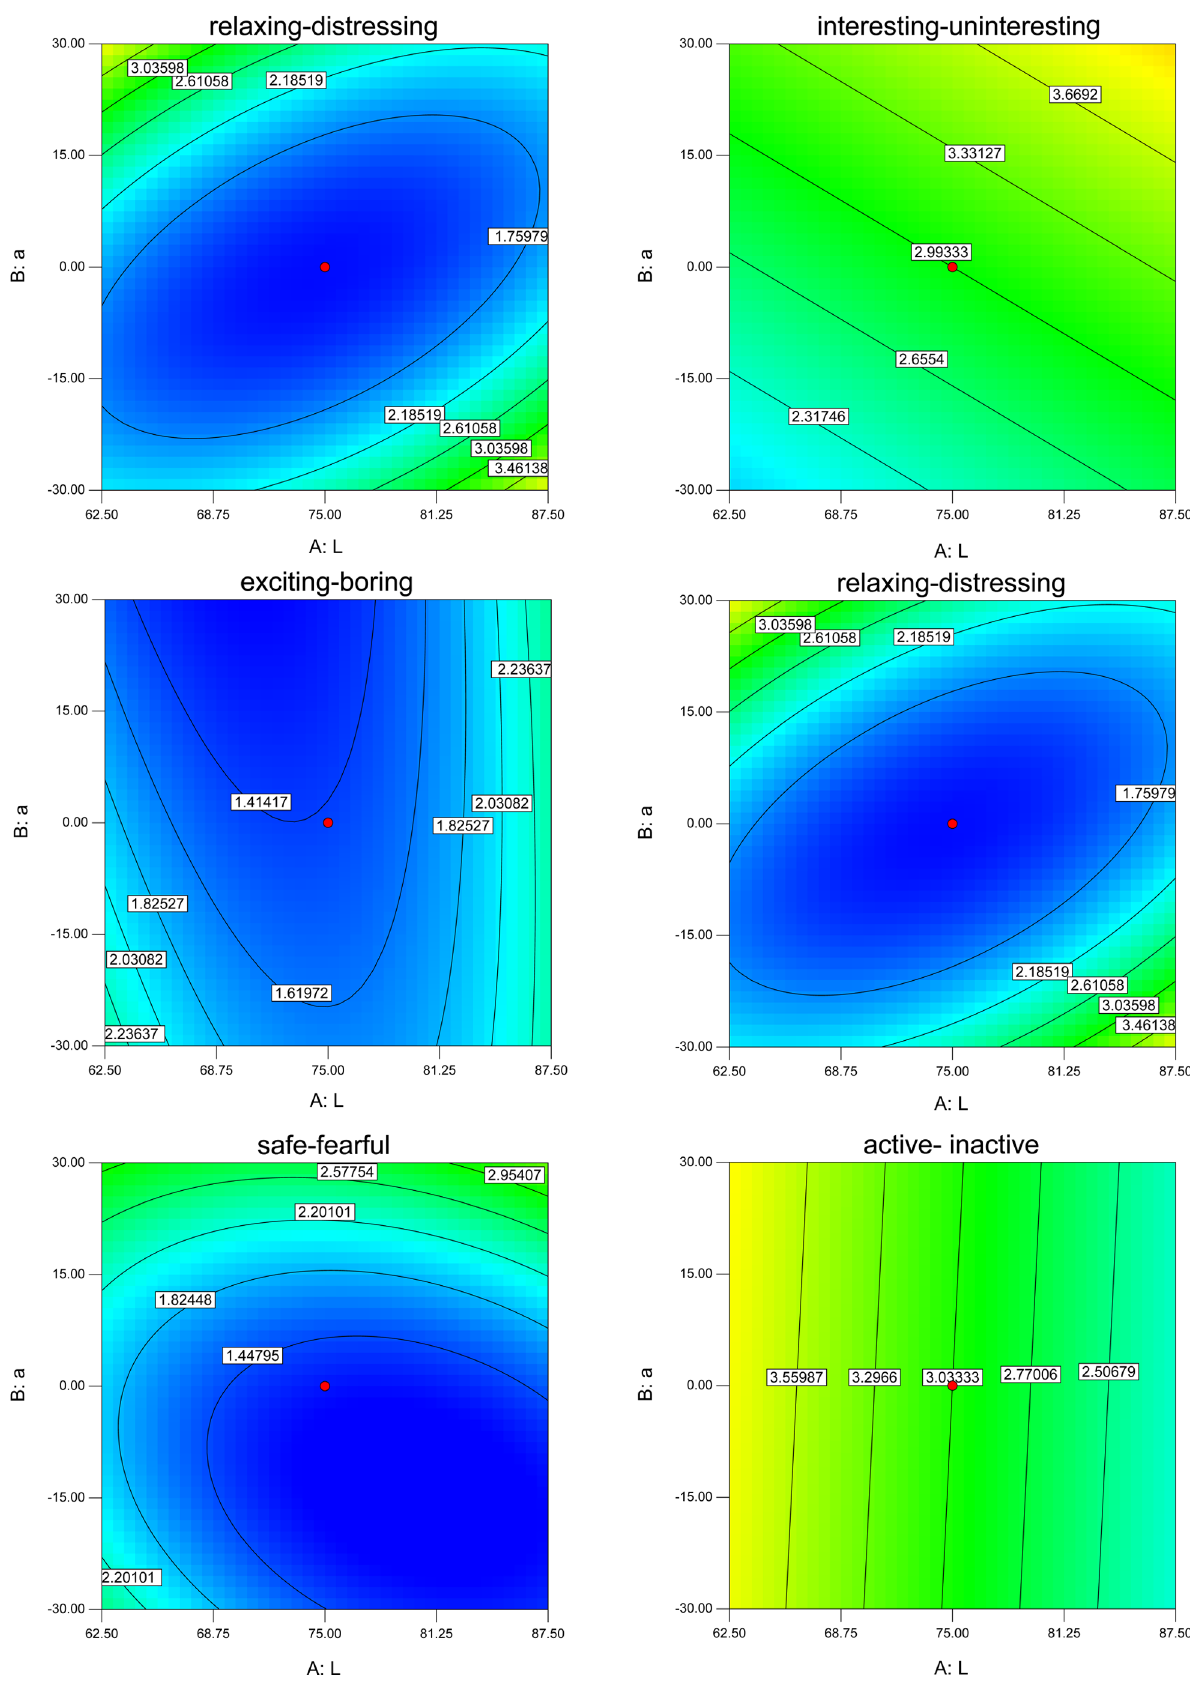
Figure 6. The contour plots for 6 responses. doi:10.1371/journal.pone.0090646.g006 PLOS ONE |